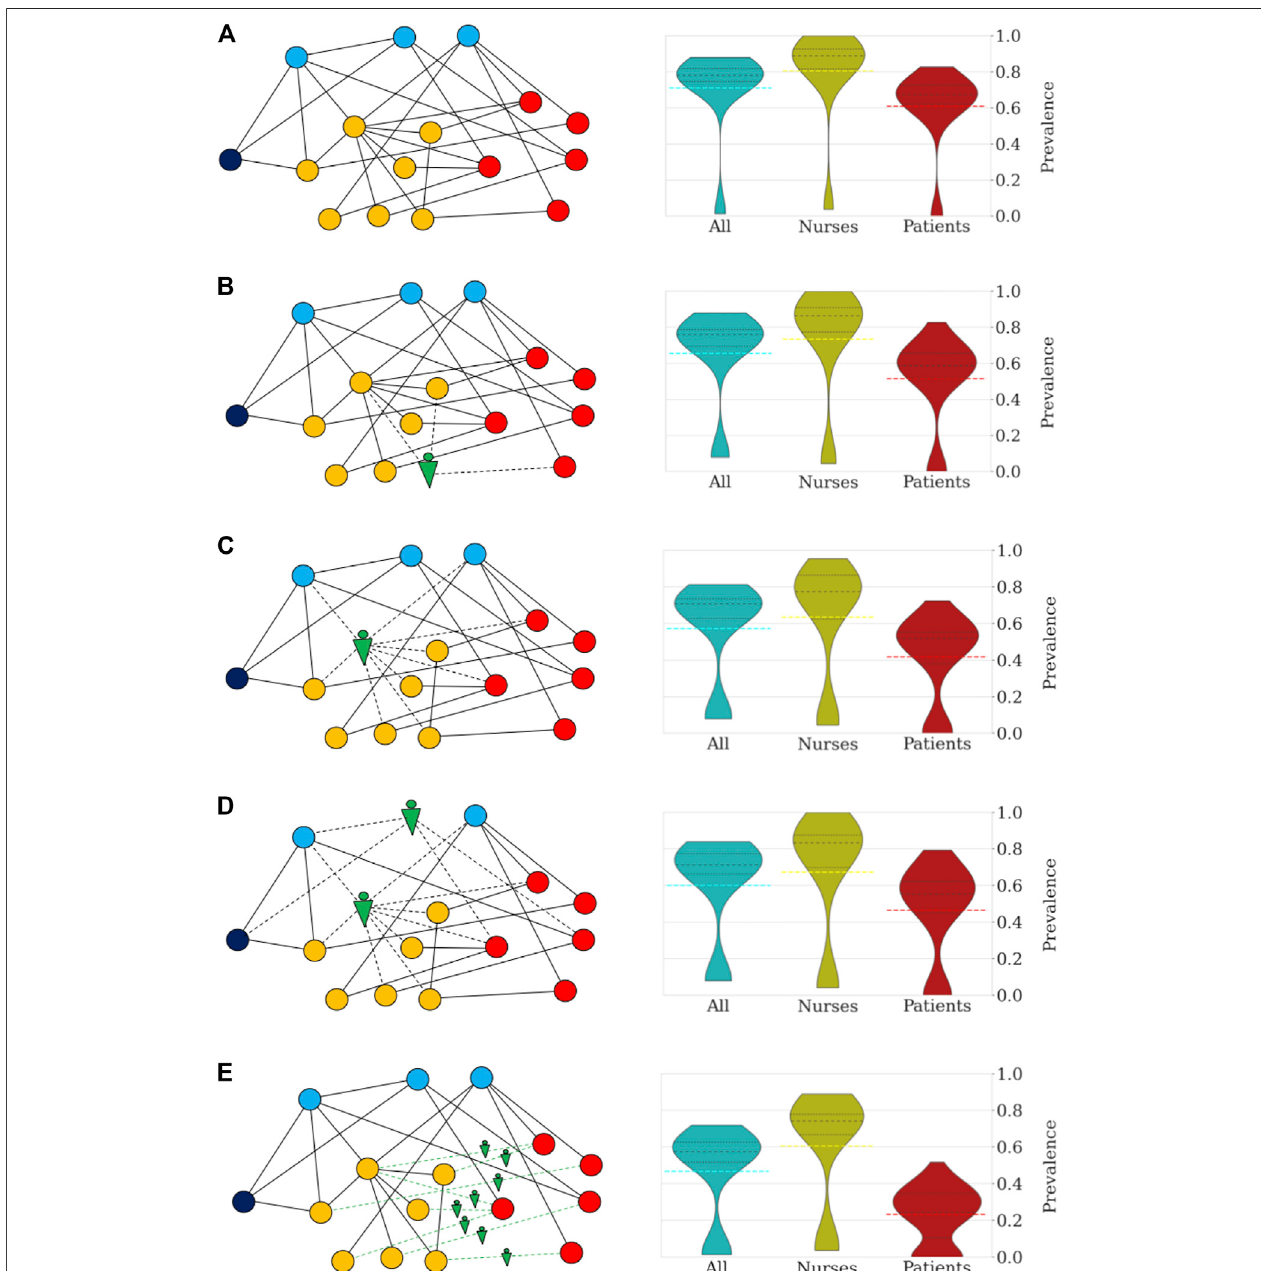
FIGURE 1 | Robotization scenarios and their impact on the probability of pathogen spread through the network and number of infected individuals (R 0 (cid:1) 4.4). The networks on the left side depict sketches of the networks of close contacts at the geriatric ward under different scenarios. The colors indicate the categories: patients (red),nurses(orange),doctors(blue),administration(darkblue),androbots(green). (A) Inscenario(i)noroboticassistanceisprovidedandthenetworkofclosecontacts remains intact. (B) Scenario (ii) is illustrated bya random nurse being replaced bya robot. (C) In scenario (iii) high-risk nurses are being replaced. (D) Scenario(iv) is illustrated by the robotic replacement of a high-risk nurse and a random doctor. (E) In scenario (v) the robotization affects the interactions between nurses and patients. The right side of each panel shows the distribution of prevalence of infection (percentage of individuals infected) under the different scenarios. All simulations were repeated 100 times to obtain the distributions shown in the violin plots and percentile statistics. For each violin plot, the dashed black lines indicate the different quartiles ofthedistribution whiledashed colorlinesmarkthemean. (A) Intheabsenceofroboticintervention, thedistributionofthenumber ofinfectedcasesisbimodalwith10% of trials in which the infection does not spread. Across all trials, an average of 71% of the personnel and patients become eventually infected. In general, the nurses and doctors are more vulnerable to becoming infected than patients and administrative workers. (B) Random replacement of fi ve nurses increases the percentage of non- spreading trials to 16%. This intervention has the effect of decreasing the average number of infected individuals (66%). (C) The situation improves further when the fi ve nurses are selected according to the number of contacts. In this case, the probability that the infection does not spread increases to 21% (more than doubling the case